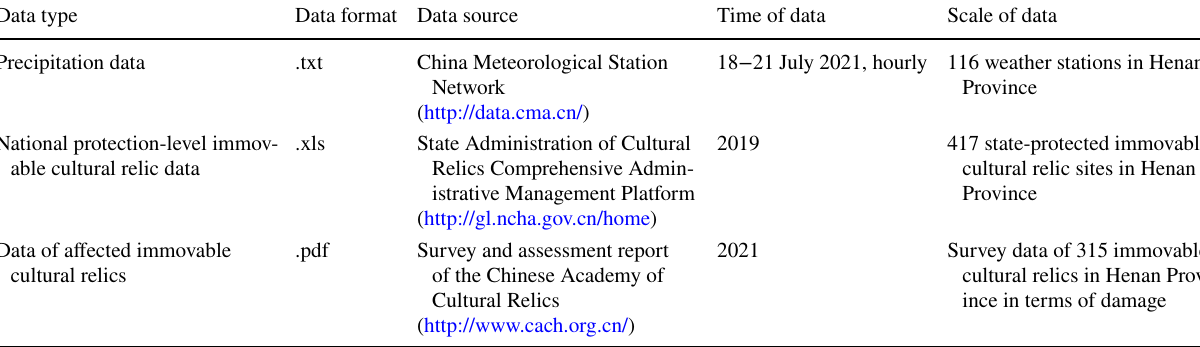
Table 1 Sources and specific information of the data from Henan Province used in this